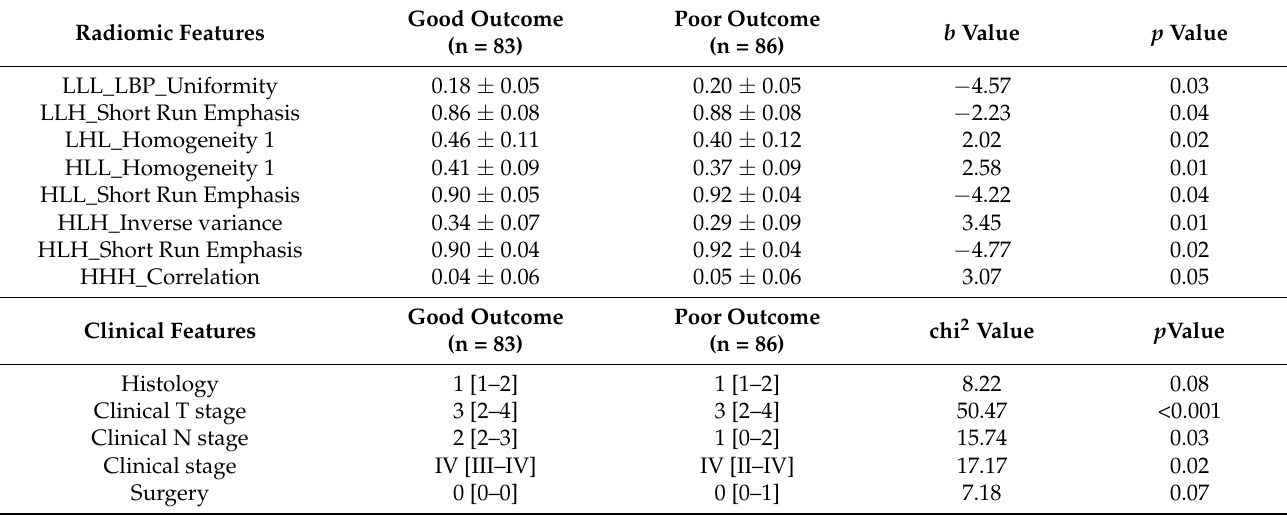
Table 2. Predictors for model building. Eight radiomic features and five clinical features were selected as predictors for model